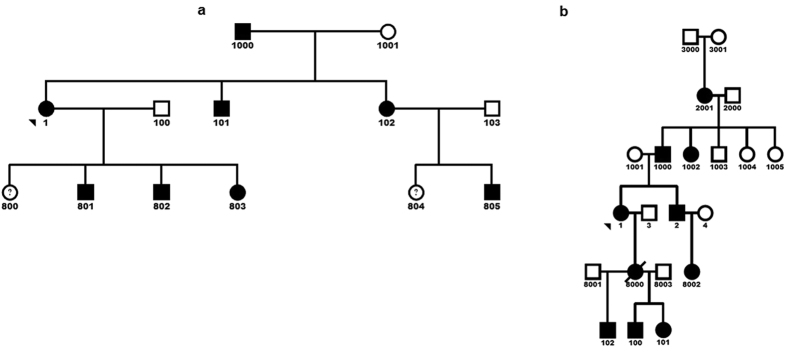
Pedigree of two families with FSGS.(a and b) There are at least 18 affected individuals in the two families. There is clear male-to-male transmission in both families consistent with an autosomal dominant mode of transmission. Arrowheads identify the proband in both families. DNA samples from individuals 1, 805 and 1000 in Fig. 2A were subjected to whole exome sequencing.